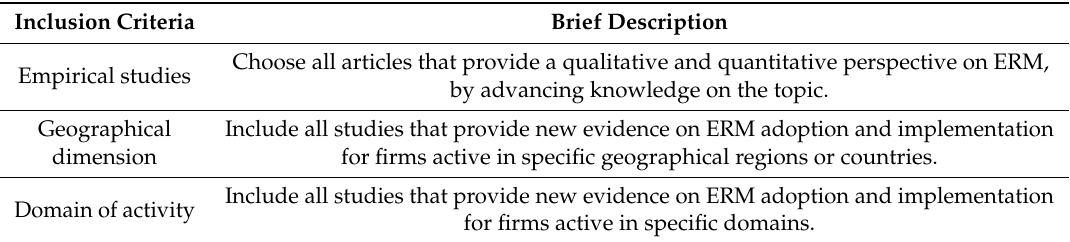
Table 2. Inclusion Criteria for the Systematic Literature